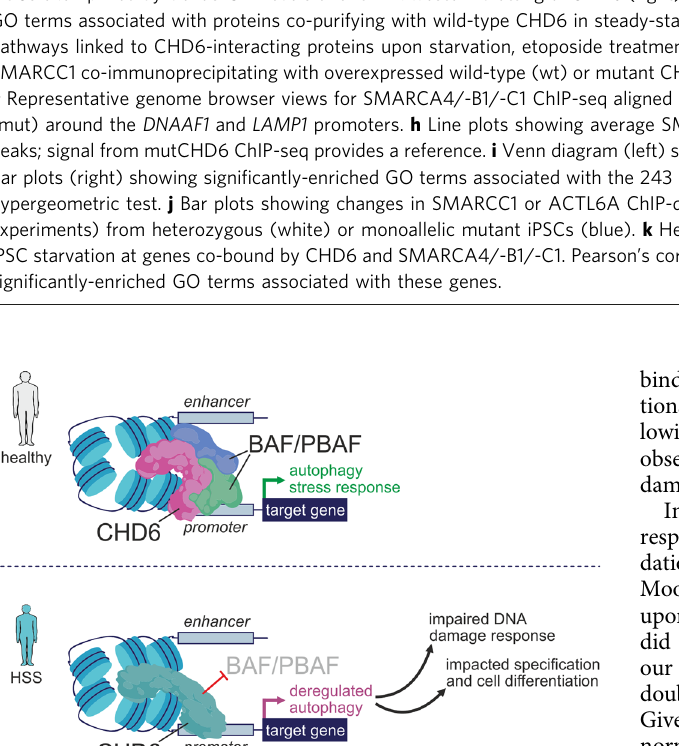
Fig. 5 A model for HSS-relevant effects of the CHD6 mutation. In individuals with wild-type CHD6 (top), co-recruitment of CHD6 and BAF/ PBAF complexes to the promoters of autophagy genes ensure proper gene regulation in response to pro-autophagy and stress cues. In those carrying the I1600M mutation, the recruitment of BAF/PBAF co-factors is hindered and autophagy control is deregulated; as a result, the DNA damage response is compromised, senescent cell features emerge, and cell differentiation and speci fi cation processes can be